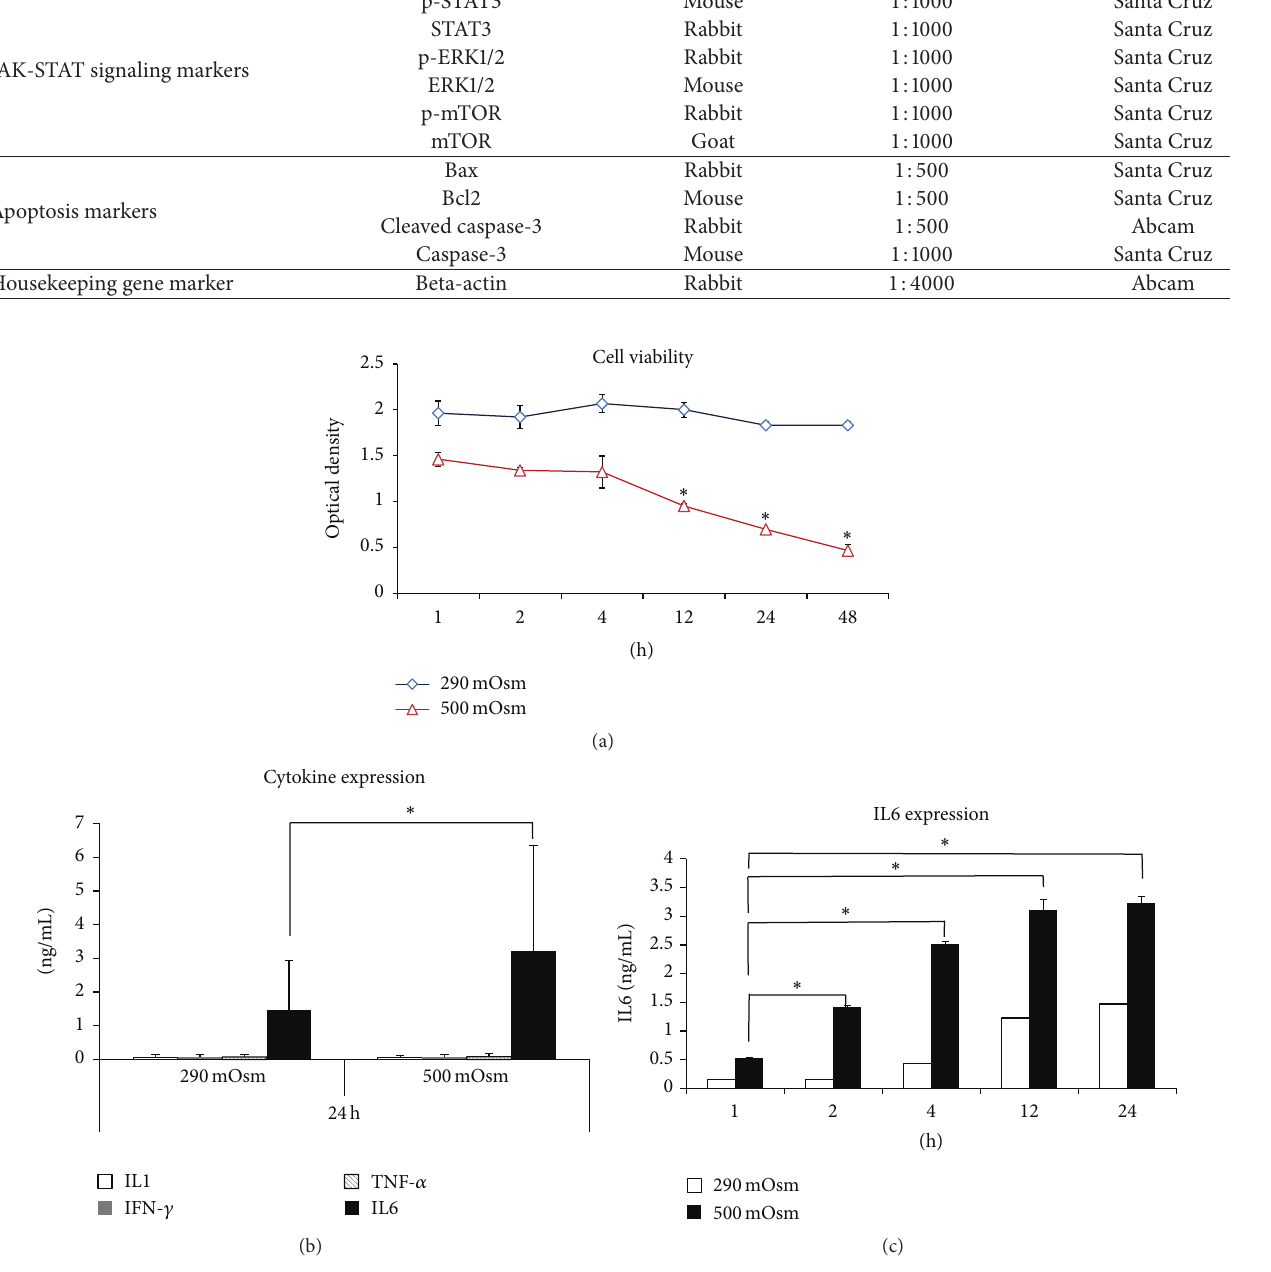
Figure 1: Change of conjunctival epithelial cells under 290 mOsm and 500 mOsm conditions. (a) Cell viability was significantly decreased in 500mOsm at 12, 24, 48 h compared to 290mOsm. (b) Cytokine ELISA assay showed 500 mOsm was significantly increased compared to 290 mOsm in cell supernatant. (c) IL6 increased depending on the time course, and the expression was higher in 500 mOsm than that in 290 mOsm. ∗ 𝑝 = 0.05 , 𝑛 = 3